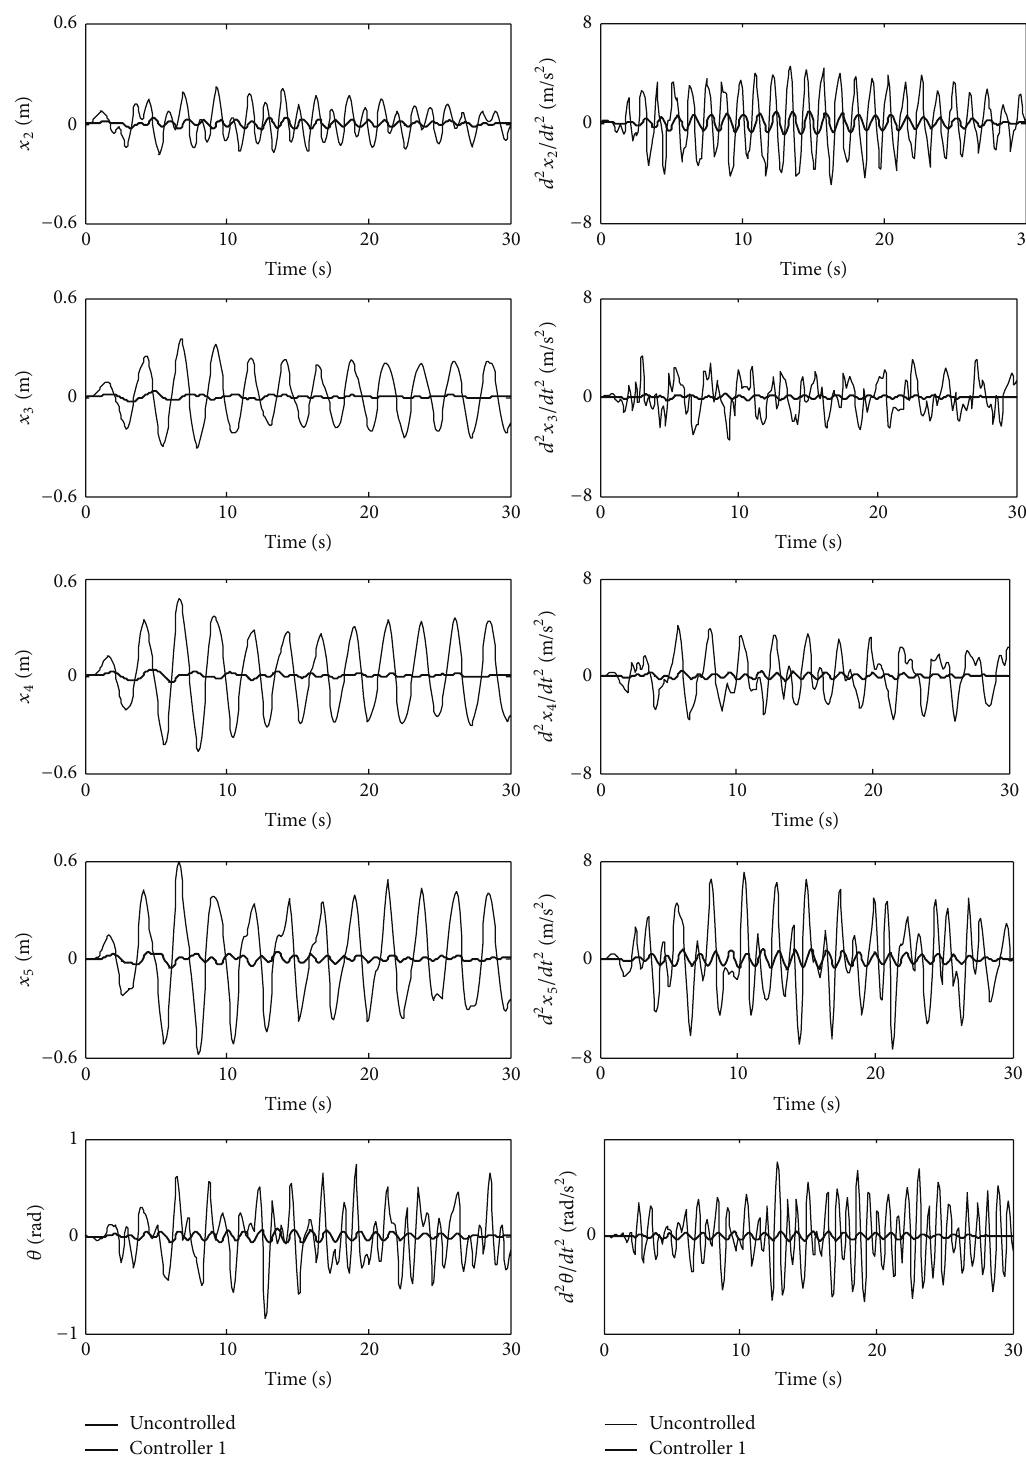
Figure 6: Time responses of the container crane against El Centro